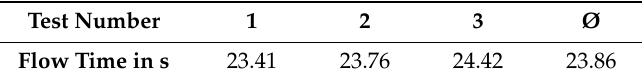
Table 5. Results of Hall flow test [13].